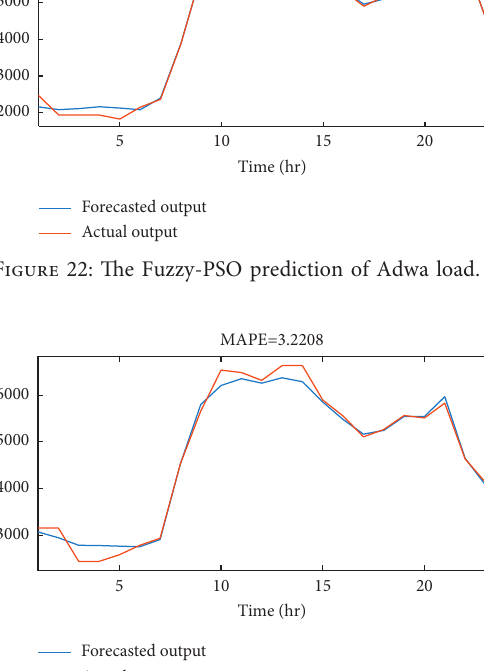
Figure 26: Correlation between forecast load and time for total system load.